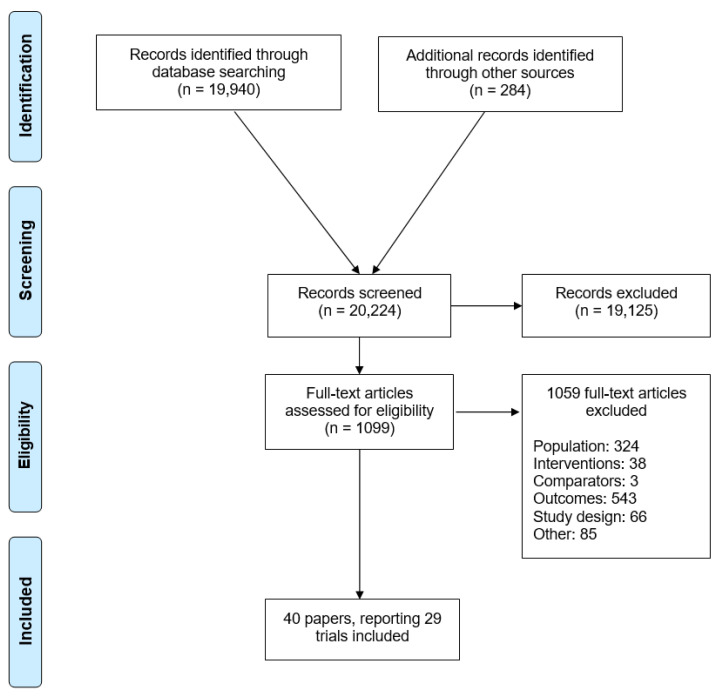
Study selection.